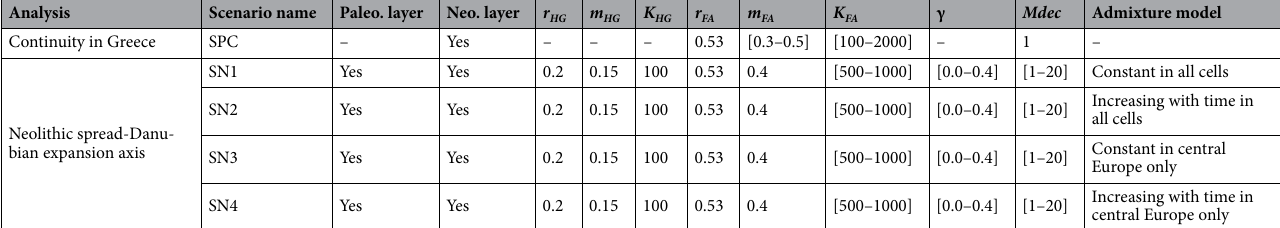
cell is made up of two separate demes representing hunter-gatherers and farmers, respectively, resulting in two superimposed layers of demes over the whole map. The two superimposed populations in one cell compete and may admix, as described below. This modified version of SPLATCHE2 allows for varying admixture through time, varying competition through space, and a reduction of the local migration rate using the new parameter Mdec (see below). The first layer, termed HG for hunter-gatherers, represents the expansion of a Palaeolithic population starting around 1600 generations ago (~ 40,000 years considering a generation time of 25 years) with 100 individuals from an arbitrary deme set in the Near East (P in Fig. S1, Table 1). The parameters used for the HG layer were fixed based on previous knowledge. They serve to fill the map with pre-Neolithic populations and no inferences were made for this layer. Each deme has a carrying capacity ( K HG ) of 100 effective haploid females, which cor- responds to 200 individuals (males and females) per cell and a human density of 200*3/10,000 = 0.06 individuals/ km 273,74 , assuming that the census size was three times the effective population size 75 . The migration rate ( m HG ) and growth rate ( r HG ) were set to 0.15 and 0.2, respectively, to achieve a colonization of Europe in approximately 500 generations, following Silva et al. 71 (Table 1). The m HG represents the proportion of individuals in each deme emigrating to neighboring demes at each generation and the r HG represent the intrinsic rate of population growth per generation. The second layer, termed FA for farmers, represents the Neolithic and subsequent periods with a population expansion starting 400 generations ago (~ 10,000 years with an average human generation time of 25 years) from a deme set arbitrarily in eastern Anatolia with 100 individuals (N in Fig. S1). The initial carrying capacity of these demes ( K FA ) was estimated using a uniform prior distribution of U[500, 1000] individuals, the upper limit corresponding to the maximum density estimated for the Linear Pottery culture (LBK) of ~ 0.6 individuals/ km 276 . Eighty generations before the end of the simulations (~ 2000 years ago), the value of K FA is set to 24,000 to reflect an increase in population density during the Roman period (to ~ 14.4 individuals/ km 276 ). The migration rate ( m FA ) and growth rate ( r FA ) were set at to 0.4 and 0.53, respectively, in order to fit the dates of the advance of the Neolithic from eastern Anatolia to central Europe via Greece, following Silva et al. 71 Table 1). A Lotka-Volterra model of competition 77,78 with density dependent coefficients of competition is used to mimic the progressive disappearance of the hunter-gatherer subsistence strategy and its replacement by the farming strategy 70 . Under this model, and thanks to a higher carrying capacity, farmers from the Neolithic deme have a competitive edge over hunter-gatherers from the Palaeolithic deme located in the same geographic cell. To cope with the long persistence of hunter-gatherers in central and northern Europe 1,79 , we modified the original model 71 by lengthening the cohabitation period with farmers up to 224 generations (until 4400 years ago) in an area representing central Europe in our simulations (Fig. S1). This was done by setting the coefficients of competition to 0 in this area, then setting K HG to 0 at generation 1424. This prolonged cohabitation period allows us to sample the hunter-gatherer layer at the time corresponding to the real samples from the analysed dataset, which otherwise would be impossible since the Palaeolithic deme would be empty at the sampling date. Gene flow can occur from the Palaeolithic/Mesolithic to the Neolithic layer to represent hunter-gatherers who adopted farming or the birth of a child in the farming population with a parent from each of the two popula- tions. The amount of hunter-gatherer gene flow toward the farming population is regulated by the assimilation rate γ, where γ = 0.0 indicates the absence of gene flow and γ = 1.0 full mixing; γ represents the proportion of contacts between hunter-gatherers to farmers within a deme that results in gene flow from hunter-gatherers to farmers at each generation (see 70 for details). Therefore, this rate, which we estimate from the data, quantifies the relevance of cultural transmission during the Neolithic expansion: a value γ = 0.0 reflects a purely demic and γ = 1.0 a purely cultural diffusion of the Neolithic package. To be able to reproduce both the interpopulational and intrapopulational patterns of mitochondrial diver- sity along the Danubian route, we extended the original model of Silva et al. 71 with the additional parameter Mdec , which reflects the factor by which the Neolithic migration rate ( m FA ) is divided in a deme once 90% of the Neolithic carrying capacity ( K FA ) is reached in the same deme, and thus represents a reduction of mobility